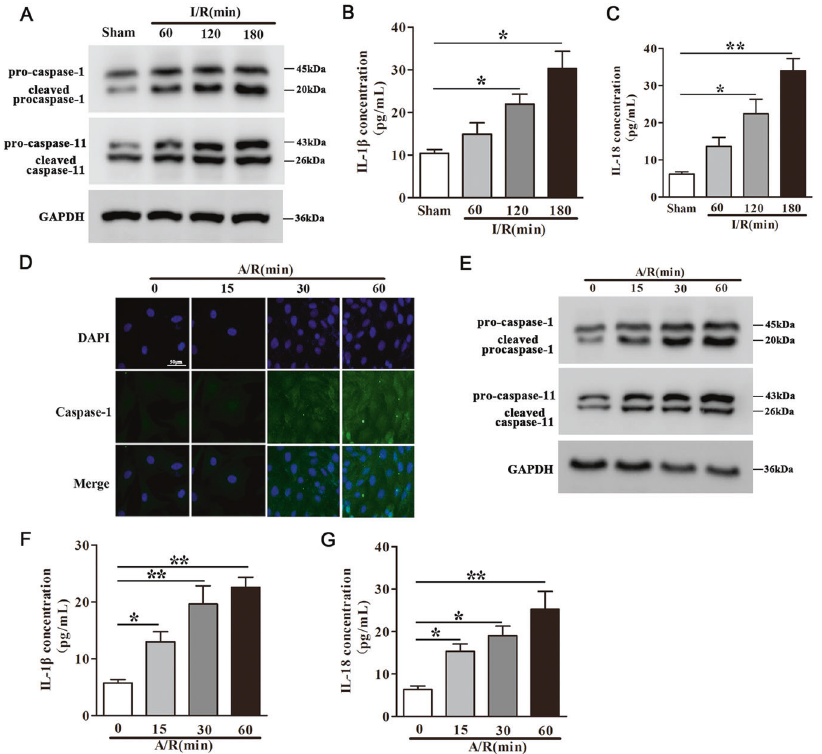
Fig. 1 Pyroptosis is activated following myocardial I/R in vivo and in cultured cardiomyocytes following A/R in vitro. In vivo, C57BL/6 mice were subjected to 45 min myocardial ischemia followed by 60, 120, 180 min reperfusion as indicated. The sham group was included as control A – C . A Relative protein expression of pro-caspase-1, cleaved caspase-1, pro-caspase-11, and cleaved caspase-11 in heart tissues were determined by western blot analysis. B , C The concentrations of IL-1 β ( B ) and IL-18 ( C ) were detected by ELISA assay. n = 6. D – G In